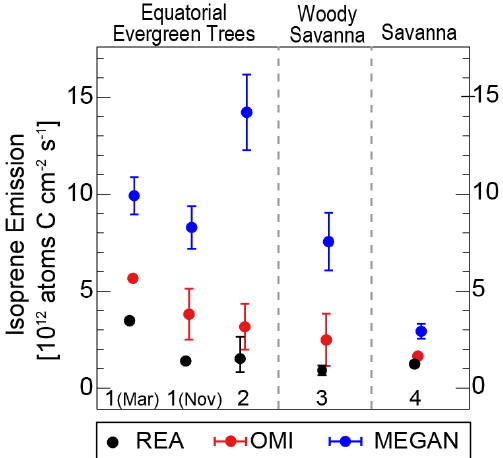
Figure 2. Mean canopy-scale isoprene emissions at African sites 1– 4 (see Fig. 1 and Table 1a) measured by relaxed-eddy accumulation (REA), and comparison to OMI-derived and MEGAN values. All values are for 12:00–15:00 local time, with diurnal correction for REA measurements at sites 2 and 3 (see text). Vertical bars on the REA measurements for sites 2–3 are the interquartile ranges over the aircraft sampling domain given in Greenberg et al. (1999). OMI- derived and MEGAN values are 2005–2009 monthly averages for the site locations and observation times, with interannual standard deviations shown as vertical bars. Mar: March; Nov: